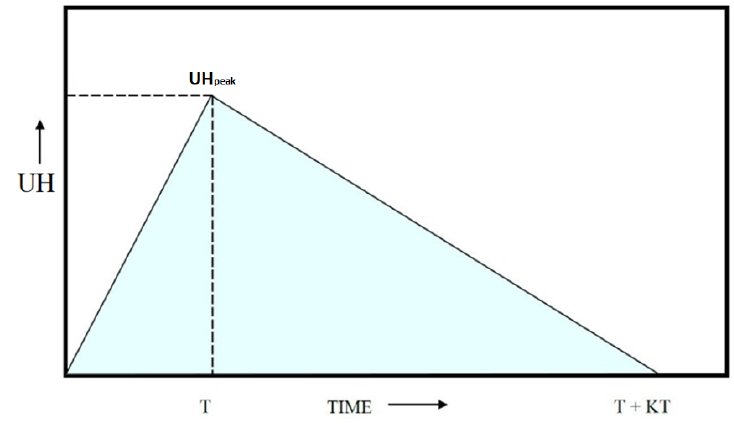
Figure 3. Example of a triangular unit hydrograph.